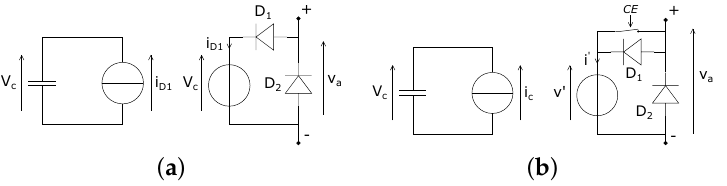
Figure 10. Averaged models for MMC simulation under faulty operation. ( a ) Averaged model of the cluster during faulty operation; all controlled devices are blocked. ( b ) Averaged model for normal and faulty operation; the switch is closed during normal operation and opened during faulty